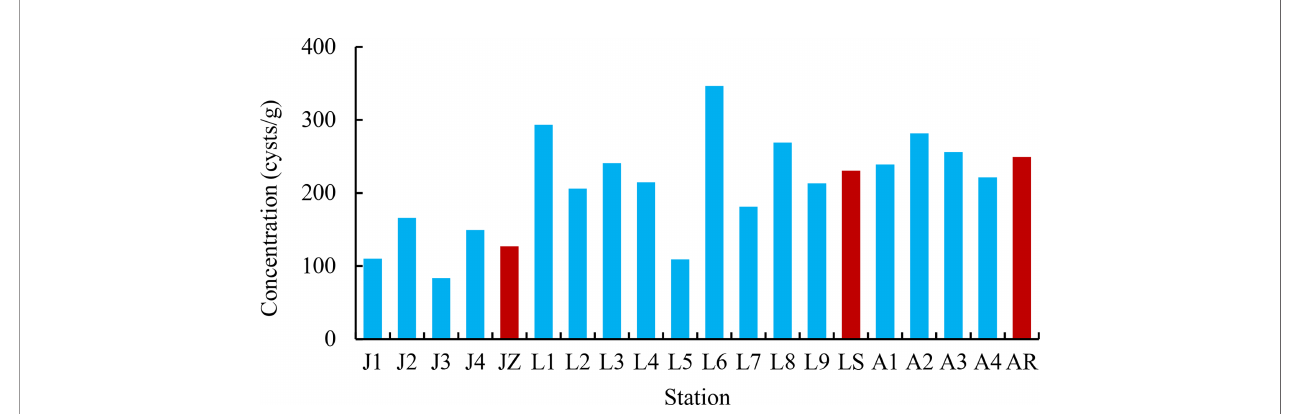
FIGURE 5 | Cyst concentration in the seventeen samples and the three sea areas. The blue bar shows cyst concentration in each sample, and the red bars present averages in the three sea